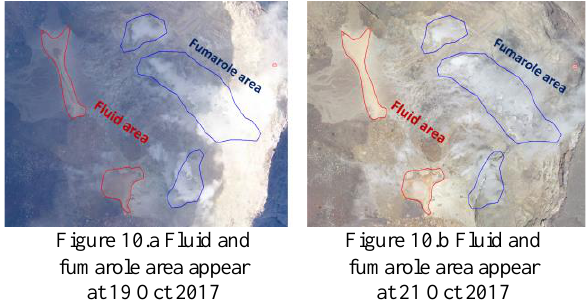
Figure 10.a Fluid